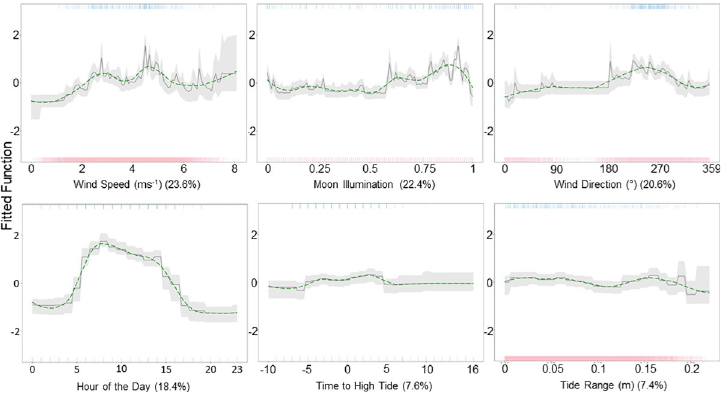
Fig 7. Partial dependency plots for Nelivaru Thila. The effect of each predictor variable on the occurrence of tagged M . alfredi at Nelivaru Thila, while keeping all other variables at their mean. The green line shows locally weighted smoothing (LOESS). Rugs display the distribution of the data for presence (top, blue), and absence (red, bottom).